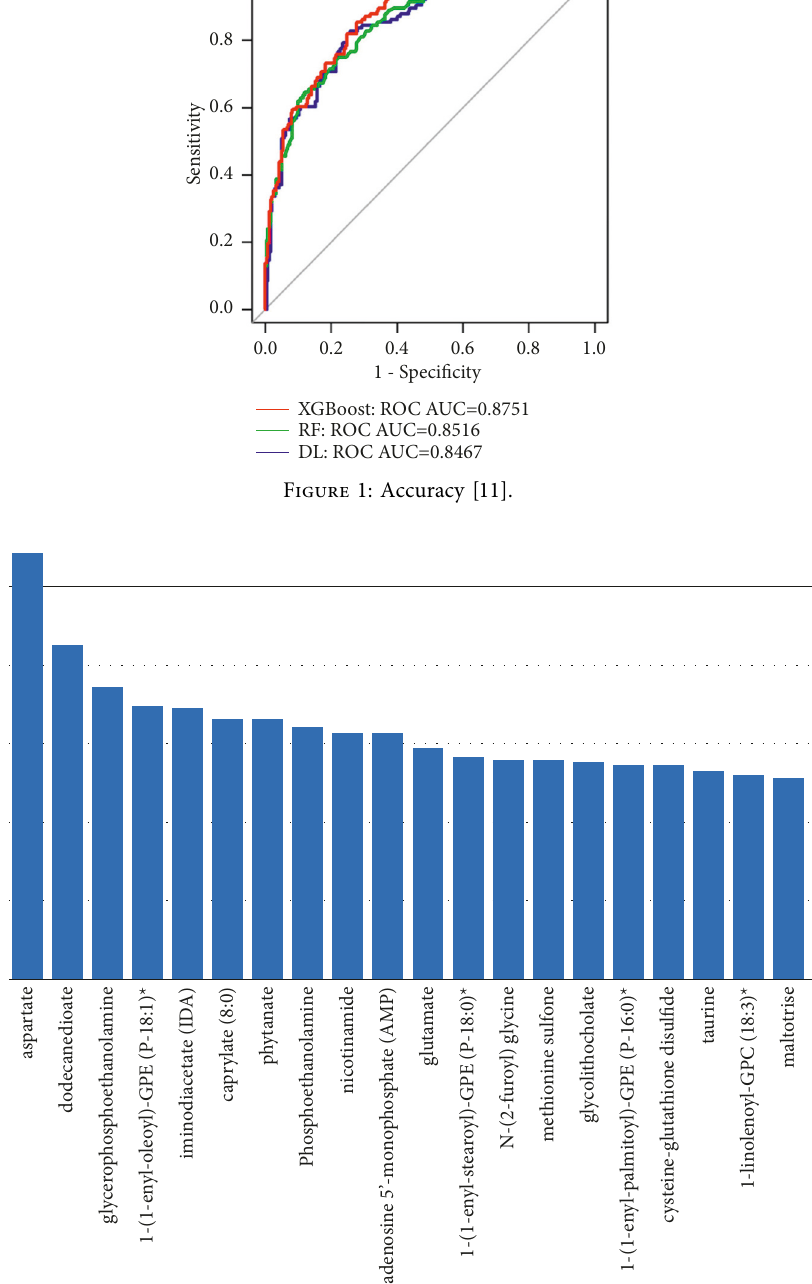
Figure 2: Metabolite biomarkers and their importance in ML algorithms for AD diagnosis [11].